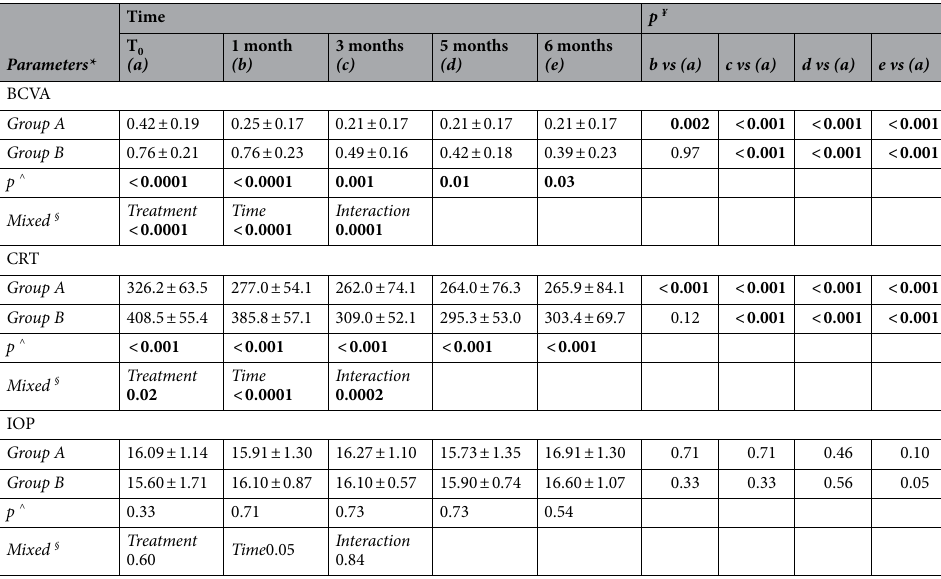
Table 2. Linear mixed-effects model to examine the effect of different treatments on BCVA, CRT, and IOP at different time-points ( n = 21 ). *As meand and standard deviation (M ± SD). BCVA Best corrected visual acuity, Contrasts of marginal linear predictions. Significant values are in